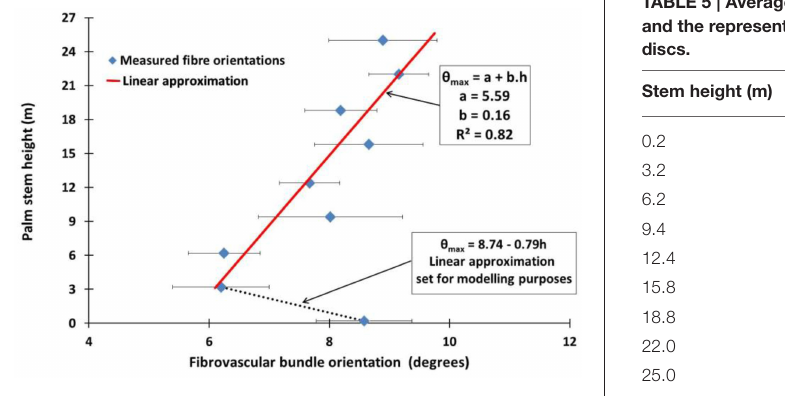
FIGURE 7 | The average maxima fibrovascular bundle degree of orientation θ max against the palm stem height is plotted in the figure. Two specific patterns can be observed. First, the average maxima fibrovascular bundle degree of orientation decreases with the stem height from 0 to 3.2m and second, quasi-linearly increases with the stem height above 3.2m. Thus, the highest deviation of fibrovascular bundles occurs toward the upper part of the palm stem where the higher flexibility of the material is needed during extreme loading conditions.